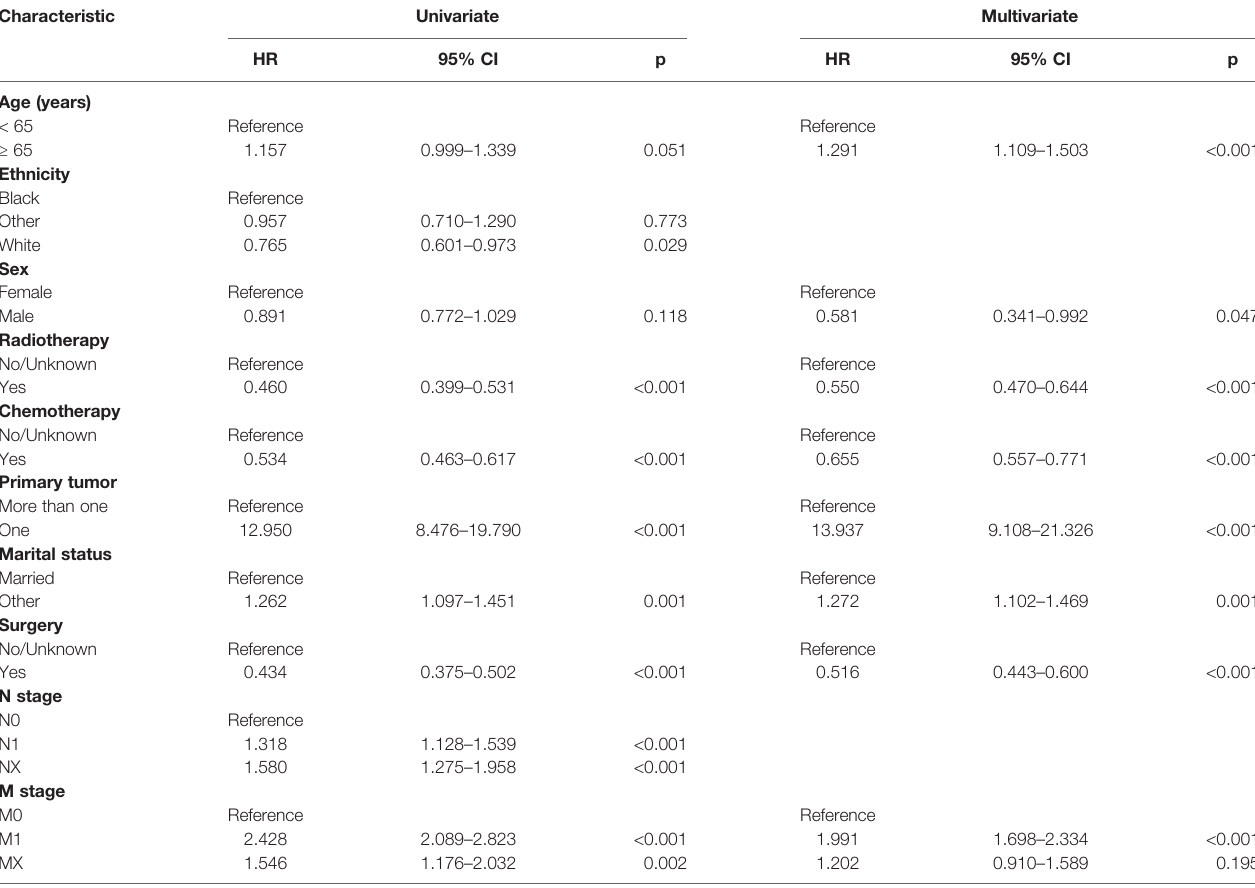
TABLE 2 | Univariate and multivariate Cox regression models of factors associated with CSS in patients with ATC. Characteristic Univariate Multivariate HR 95% CI p HR 95% CI